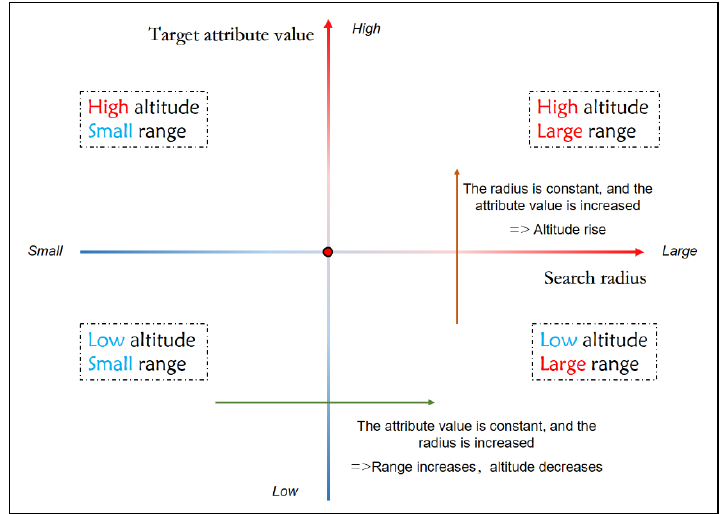
Figure 6. Orthogonal axis description of terrain parameters.